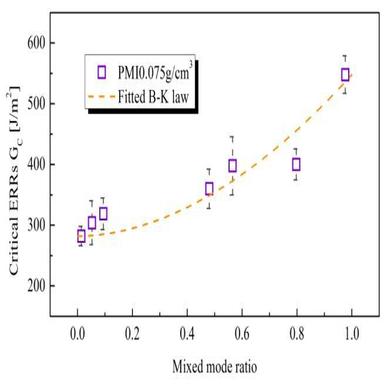
The evolution of critical mixed mode ERRs with respect to mixed mode ratio. The open scatters denote the experimental data of total critical energy release rates (ERRs) by single edge notch bend (SENB) and combined tensionshear tests. The B-K law can be fitted as the dotted curve.